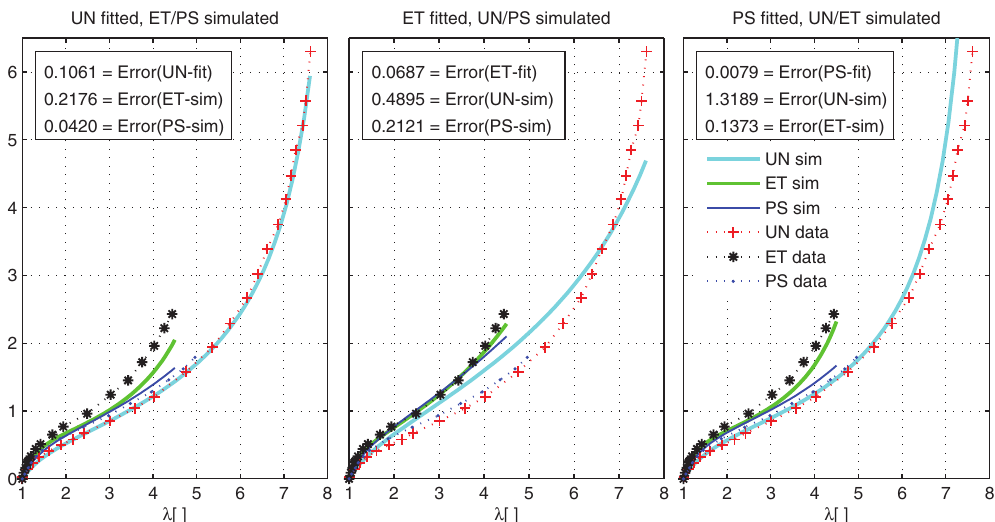
Figure 3: Performance of the Flory-Erman model modified by the eight-chain energy function on the Treloar data. The fitting quality and predictions are excellent, especially if compared to the similarly structured models, for example, the original eight-chain model or the Gent model, cf. Steinmann et al.